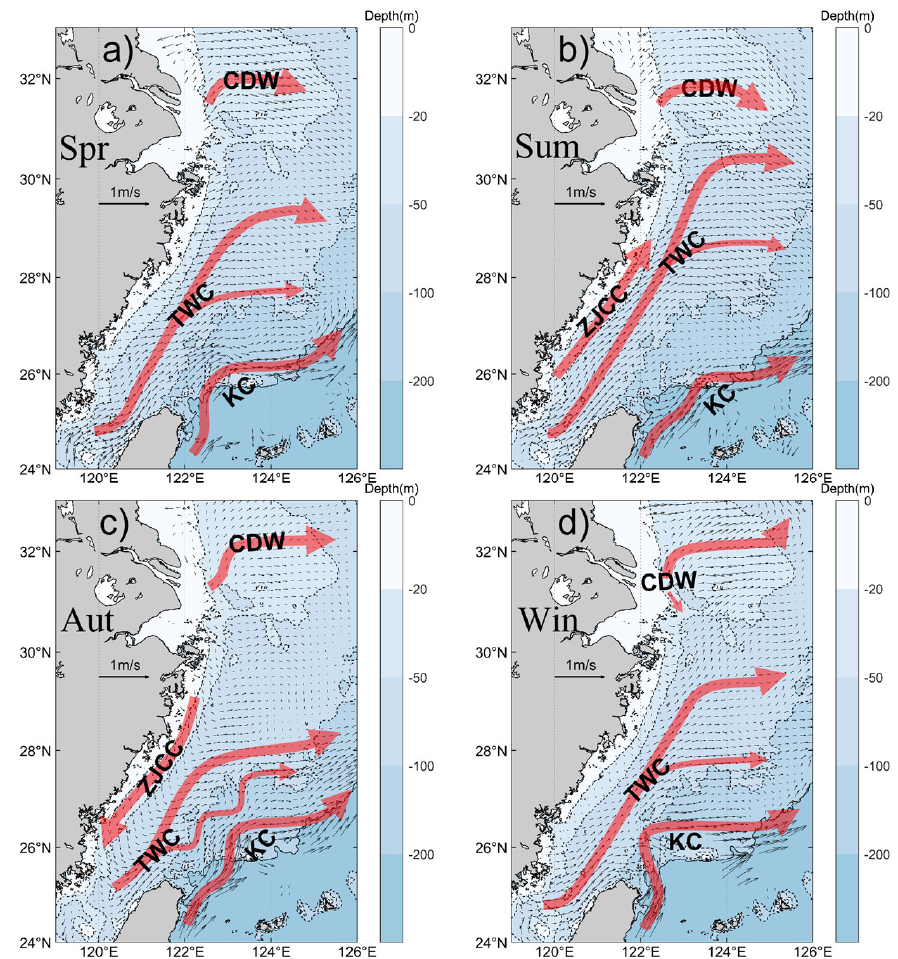
Figure 6. Seasonal surface mean flow in the East China Sea (red arrows indicate the main circulation). ( a ) Spring. ( b ) Summer. ( c ) Autumn. ( d ) Winter. KC : Kuroshio Current; TWC : Taiwan Warm Current; CDW : Changjiang Diluted Water; ZJCC : Zhejiang Coastal Current.